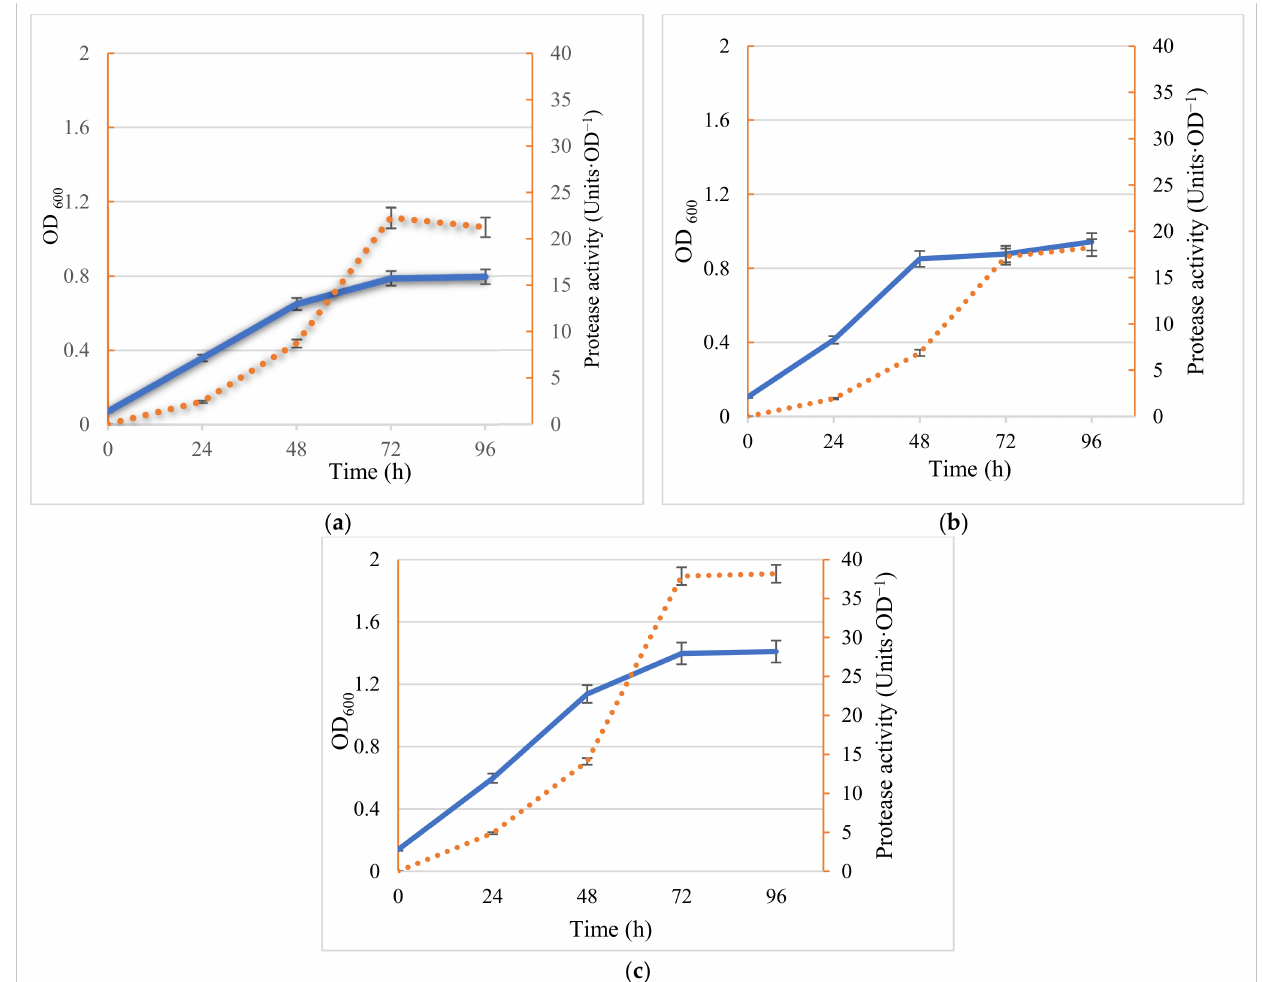
Figure 1. Cell growth (solid lines) was monitored using OD 600 and extracellular protease activity (dashed lines) was determined using casein as a substrate. ( a ) Inoculated Marinirhabdus sp.; ( b ) inoculated Marinobacter sp.; ( c ) inoculated co-culture of Marinirhabdus sp. and Marinobacter sp. Results represent the means of three experiments, and bars indicate ± standard